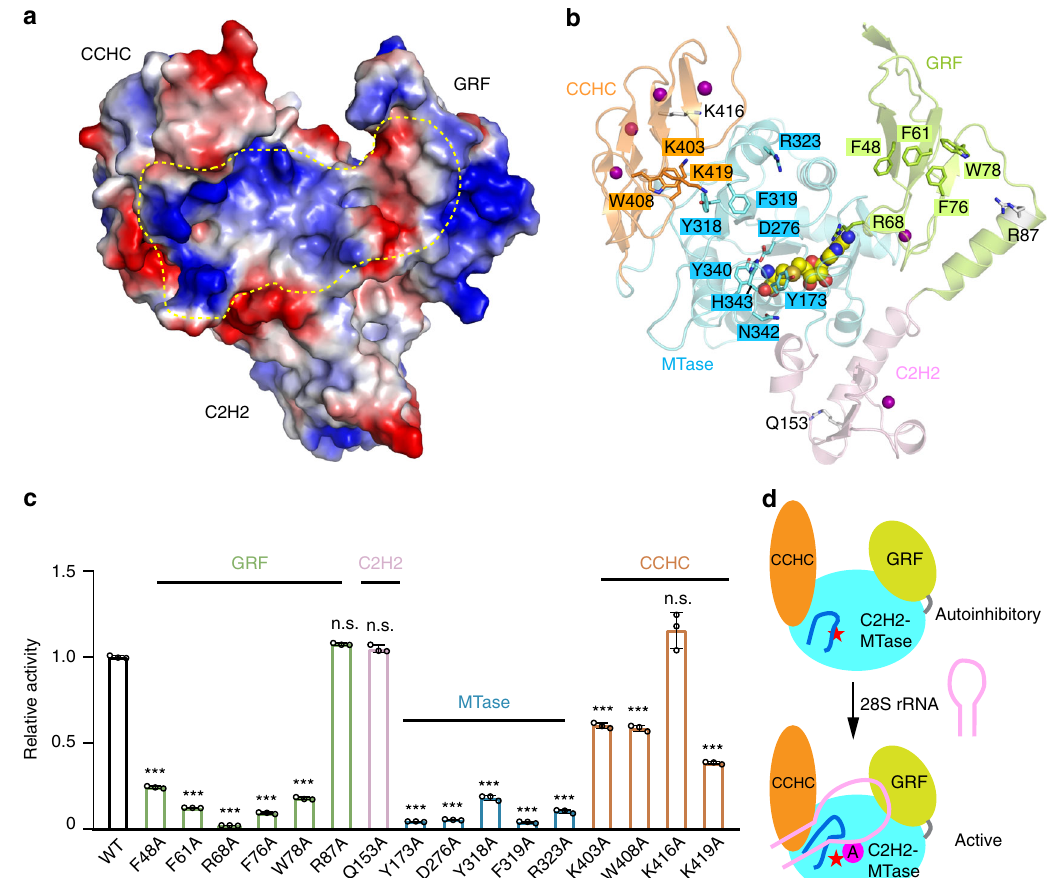
Fig. 4 Mapping of the substrate-recognition surface of ZCCHC4. a Electrostatic surface of ZCCHC4 24-464 , with the potential RNA-binding surface marked by dashed circle. b The mutational sites associated with the activity loss of ZCCHC4 are shown in stick representation and color-coded in the same fashion as the corresponding domains. The residues whose mutations failed to affect ZCCHC4 activity appreciably are shown as gray sticks. c Relative methylation activity of selected ZCCHC4 24-513 mutants over WT. The data are mean ± SD. Statistical analysis used two-tailed Student ’ s t test for the difference from WT: n.s., not signi fi cant; ***p < 0.001. Source data are provided as a Source Data fi le. d Model for the substrate recognition of ZCCHC4. The